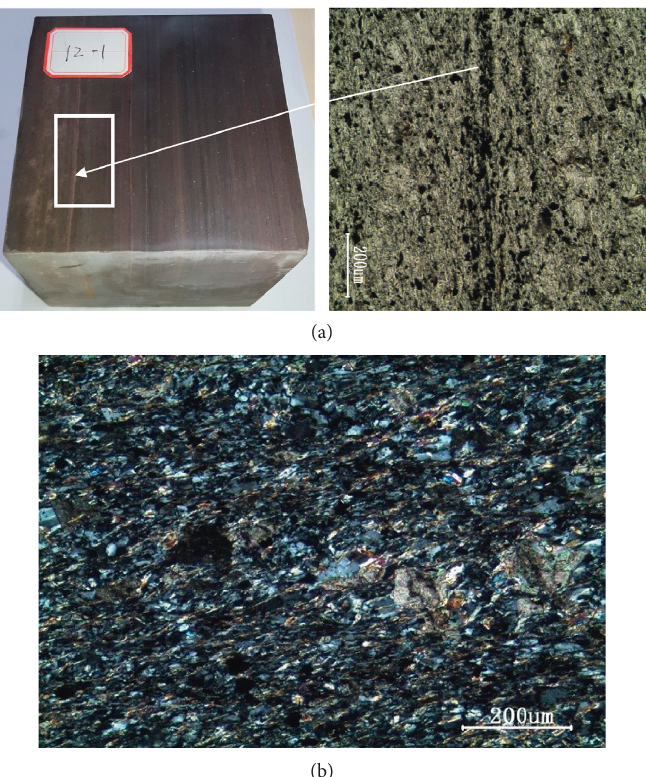
Figure 1: Macro- and microimages of slate. (a) Photomicrographs of bedding plane structure. (b). Thin section of the slate.